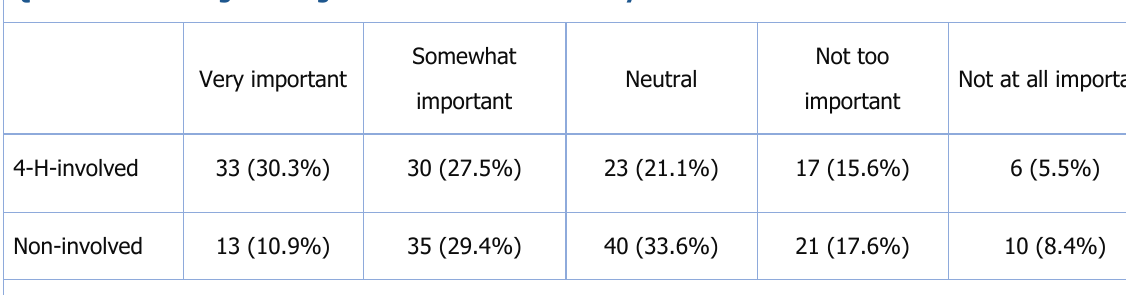
Table 3. Questionnaire Response Summary: Maintaining Civic Engagement Question 4: Feeling of being involved in the